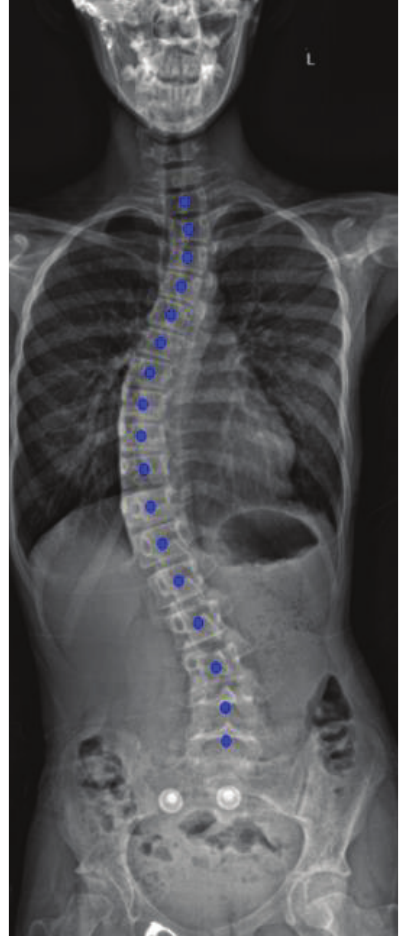
Figure 6. The result after filtering noisy